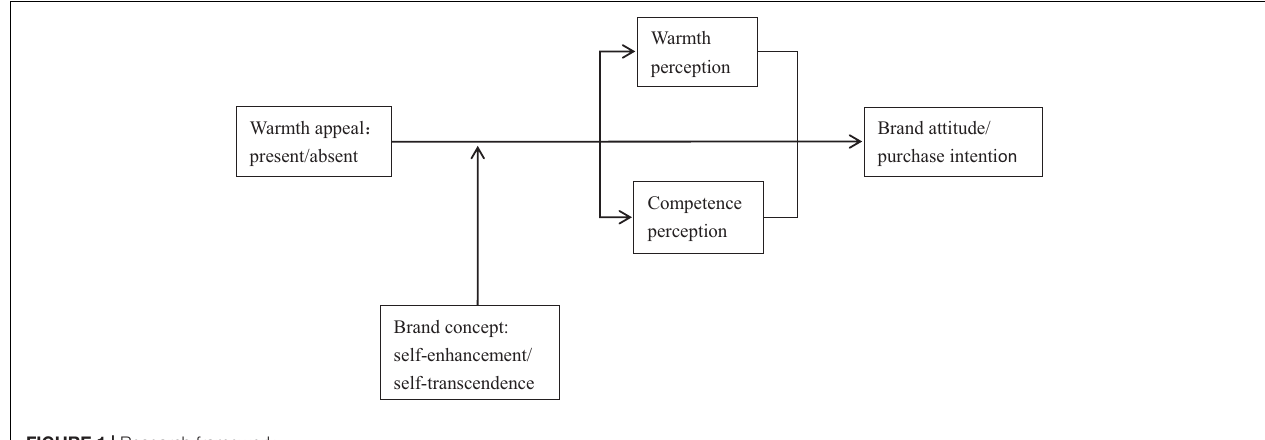
FIGURE 1 | Research